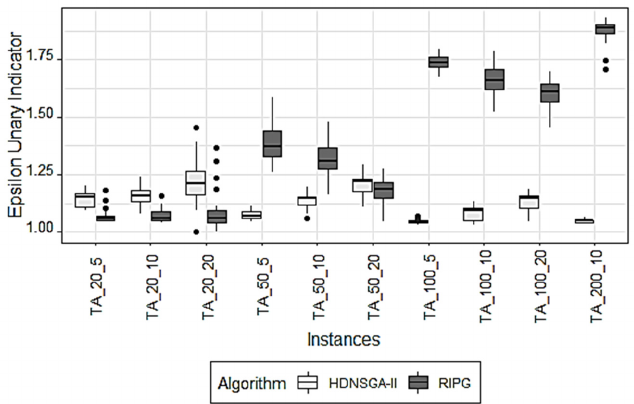
Figure 3. Comparison of the Epsilon unary indicator evolution with HDNSGA-II and RIPG in each type of instance.